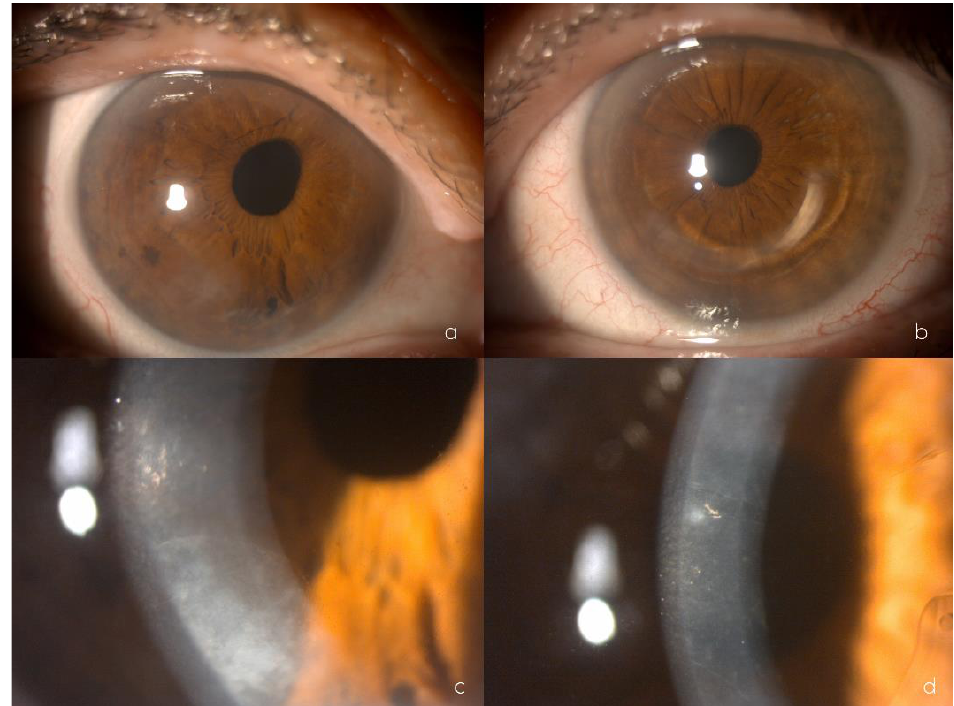
Figure 1. Biomicroscopy showing mild eccentricity of the pupil towards the upper nasal sector of the right eye ( a ), inferior intrastromal segment of the left eye ( b ), and inferior corneal endothelial opacification of the right eye ( c ), greyish polymorphic endothelial opacifications at different corneal locations and central endothelial rail tracks of the left eye ( d ).